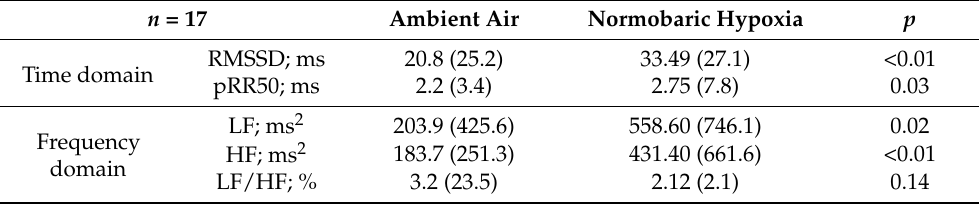
Table 2. Differences in main HRV parameters between ambient air and normobaric hypoxia. n = 17 Ambient Air Normobaric Hypoxia p Time domain RMSSD; ms 20.8 (25.2)